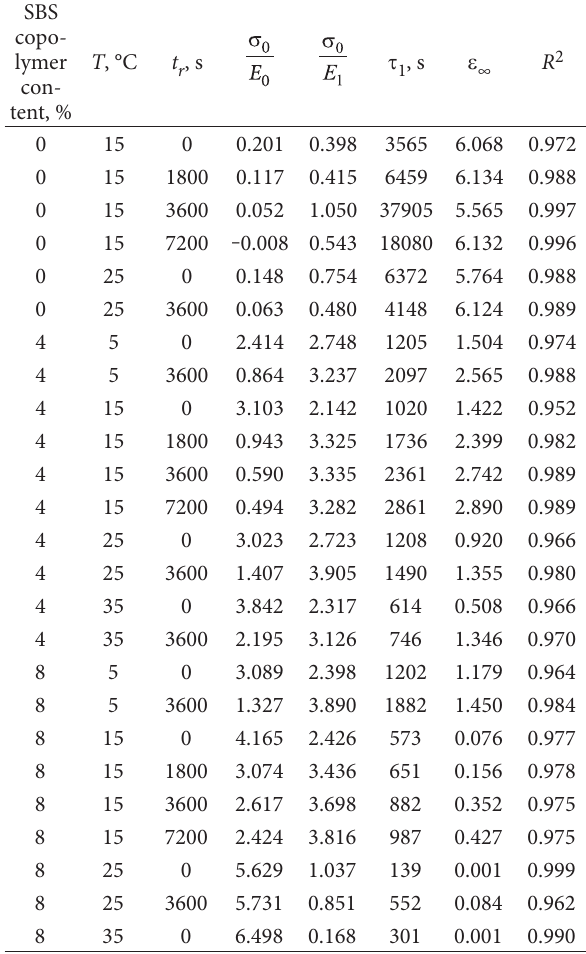
Table 2. Results of modelling of the inverse creep of the tested asphalt binders – the Burgers model parameters SBS copo-